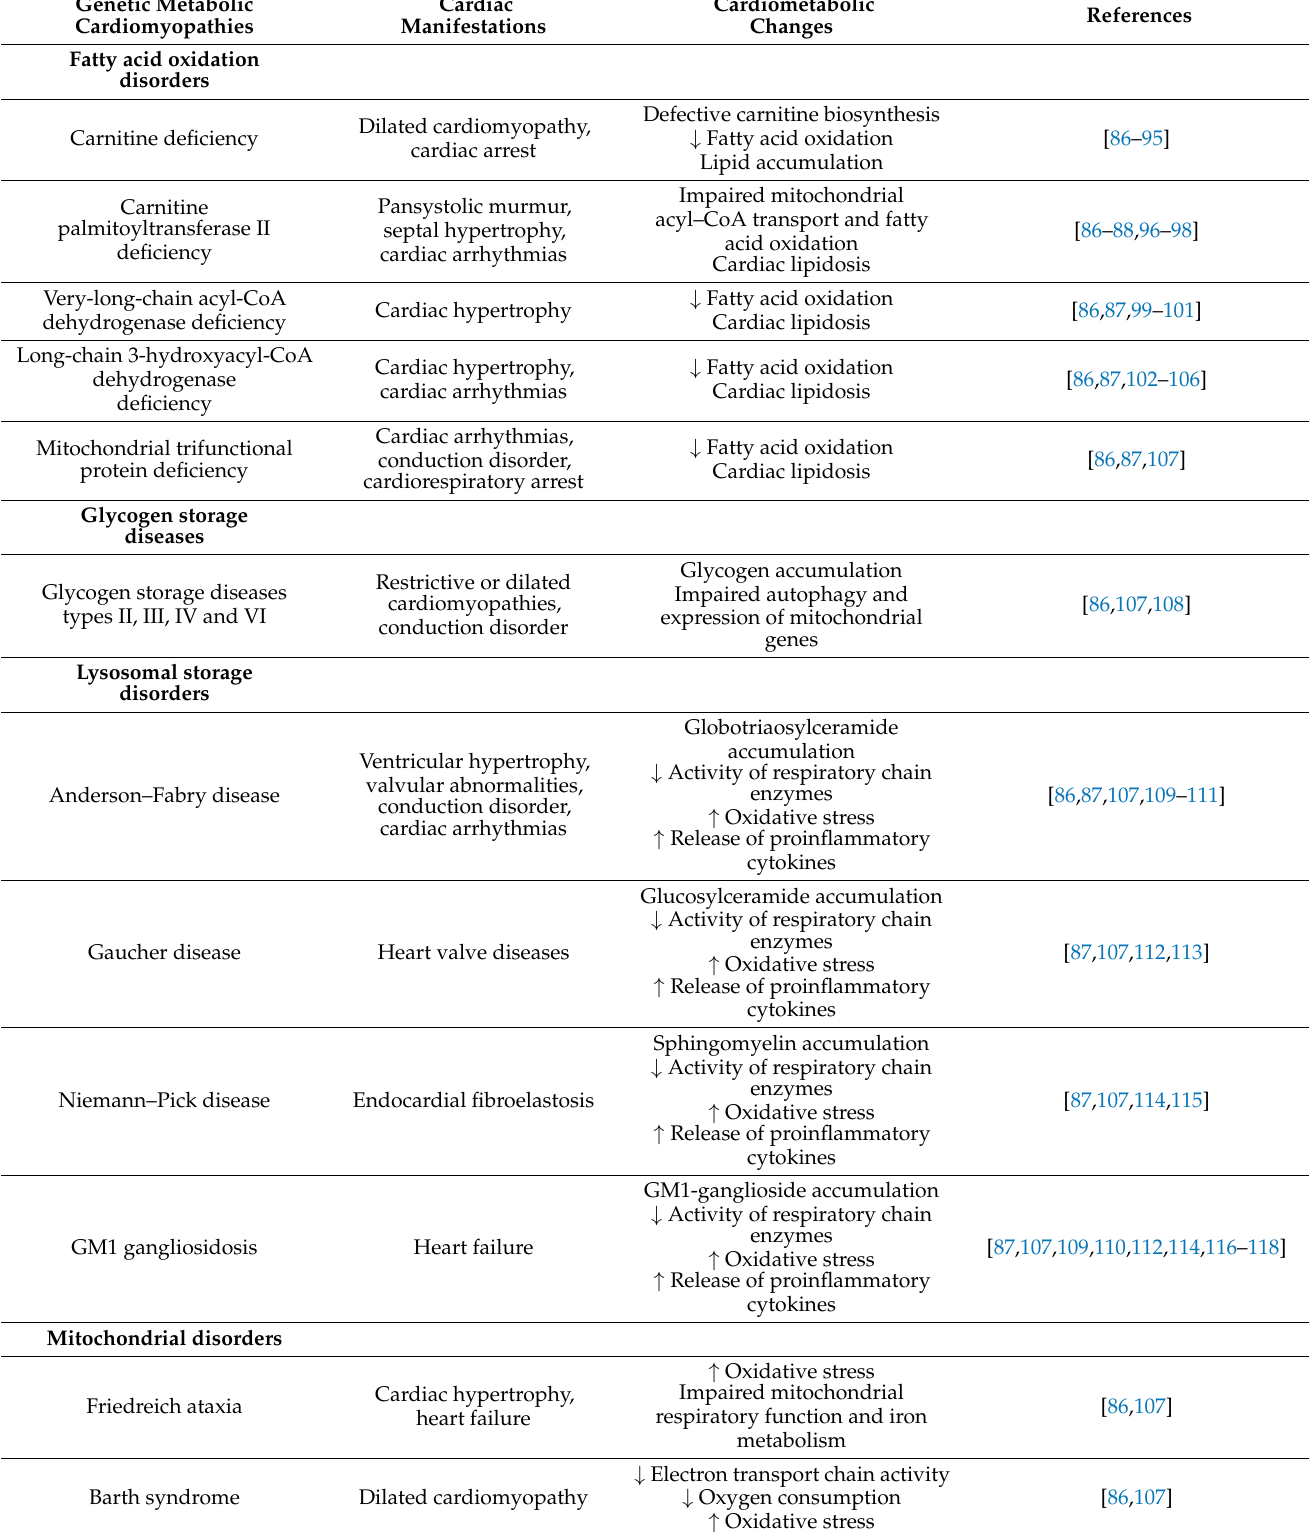
Table 1. Cardiometabolic changes in inherited